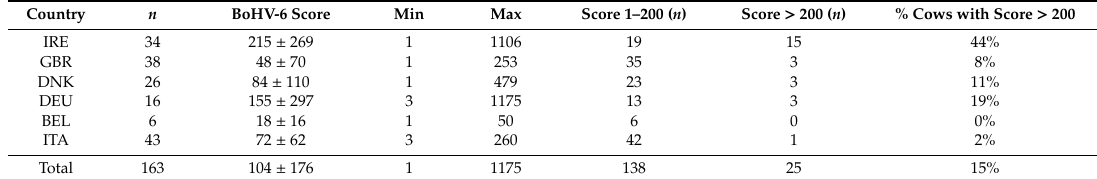
Figure 1. Individual bovine herpes virus-6 (BoHV-6) scores in dairy cows from 6 herds by country of origin (IRL, Ireland; GBR, United Kingdom; DNK, Denmark; DEU, Germany; BEL, Belgium; and ITA, Italy). The horizontal line set at 200 was taken to distinguish cows with a low (1–200) or high (>200) score. Table 1. BoHV-6 scores (mean ± SD) for the cows in the study by country of origin.